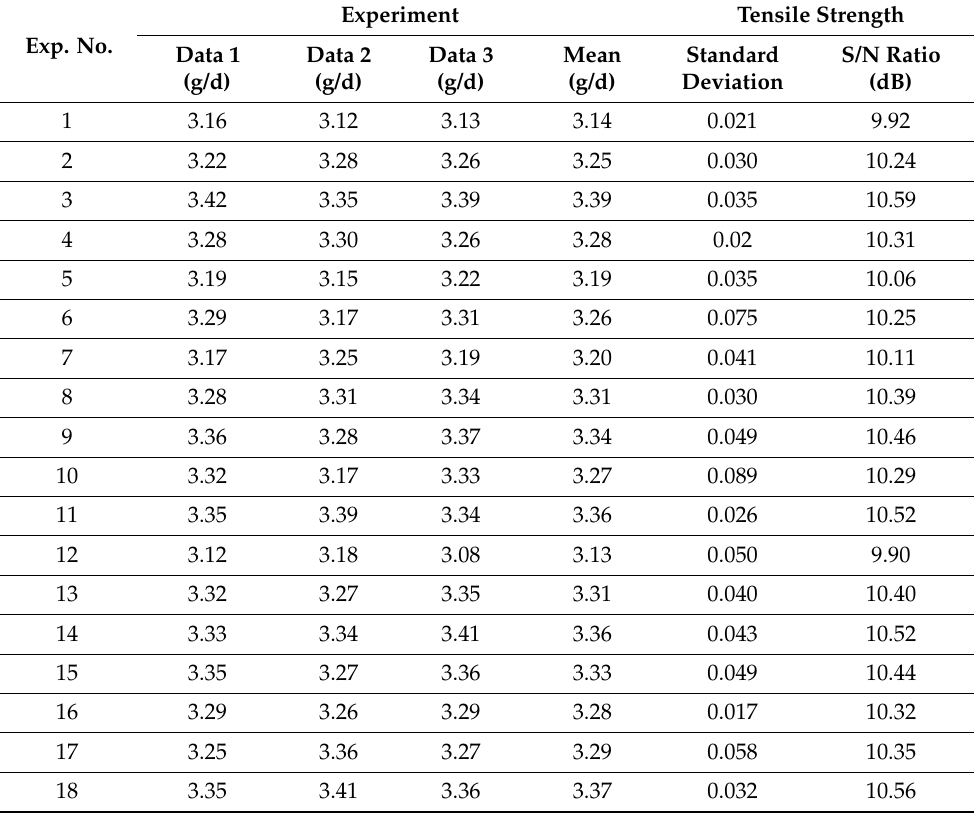
Table 7. Experimental data of tensile strength.